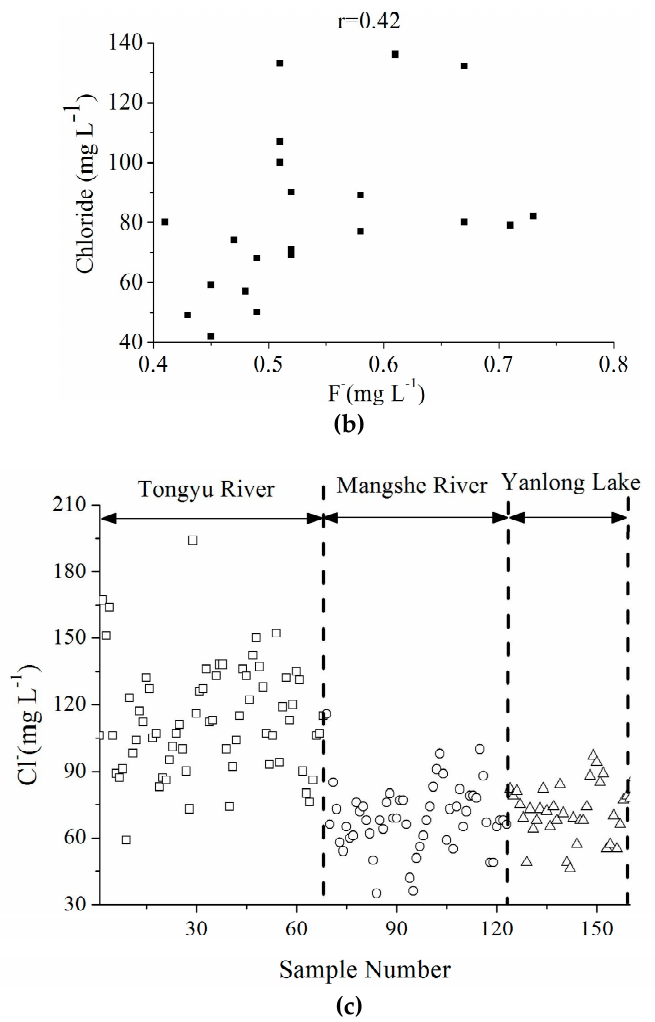
Figure 6. Relationships between F - and TAlk, F - and chloride, and chlorine contents in drinking water sources of Yancheng City ( a ) Correlation between F - and TAlk ( b ) Correlation between F - and chloride ( c ) Chlorine contents in drinking water sources of Yancheng City.